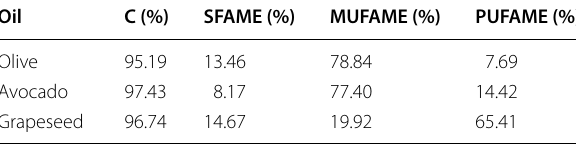
Table 1 Conversion and percentage of saturated, mono and polyunsaturated FAMEs derived from vegetable